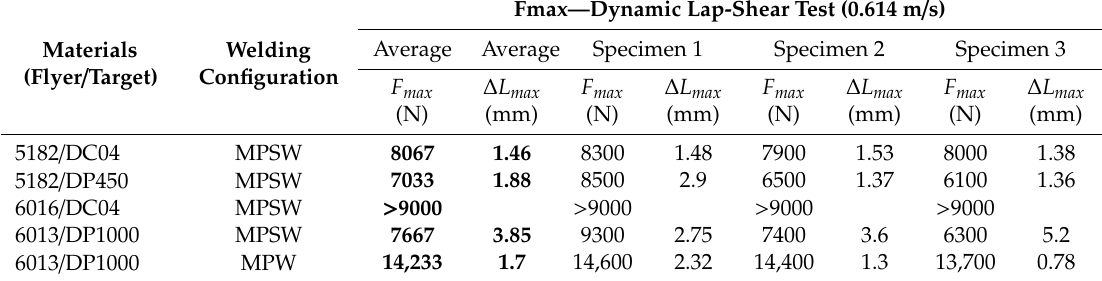
Table 12. Dynamic lap-shear tests.